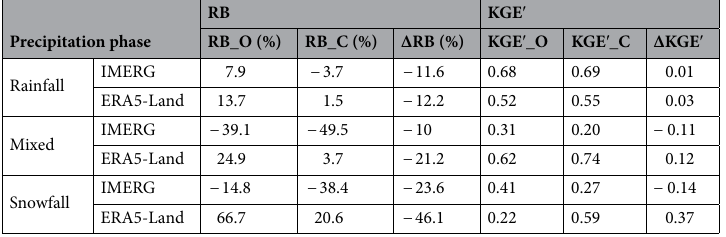
Table 6. Continuous metrics of IMERG and ERA5-Land for different precipitation